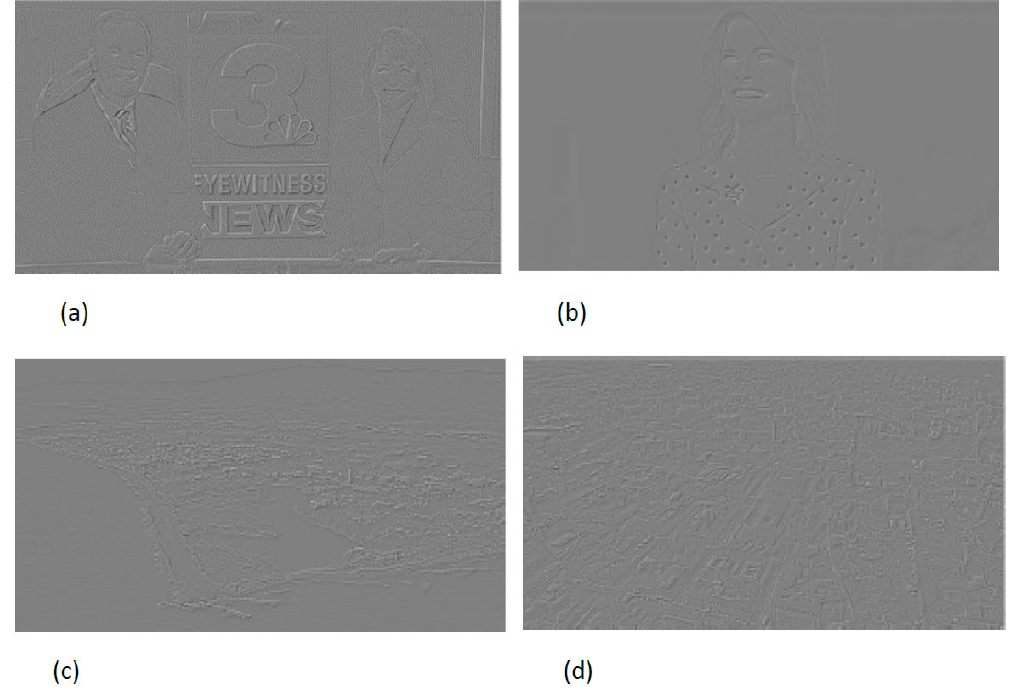
Figure 16. Level1 Difference Images for Laplacian Pyramids ( a ) News1, ( b ) News2, ( c ) Campus, ( d )